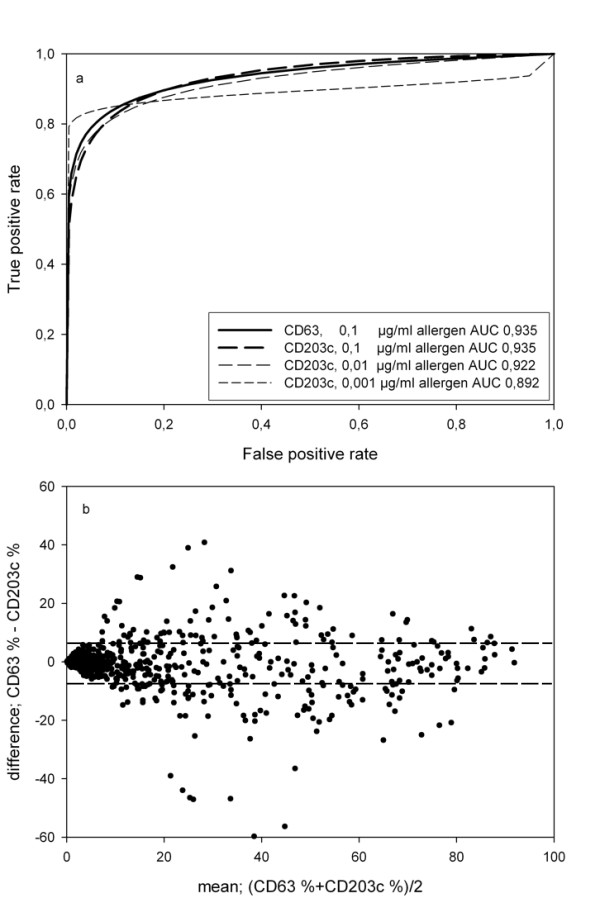
Comparison of CD63 and CD203c as readout. (a) the ROCs for CD63 and CD203c at the optimal concentration of allergen, 0,1 μg/ml, were indistinguishable. (b) Bland Altman plot of CD63-CD203c. Stippled lines indicate 25th and 75th quartiles.